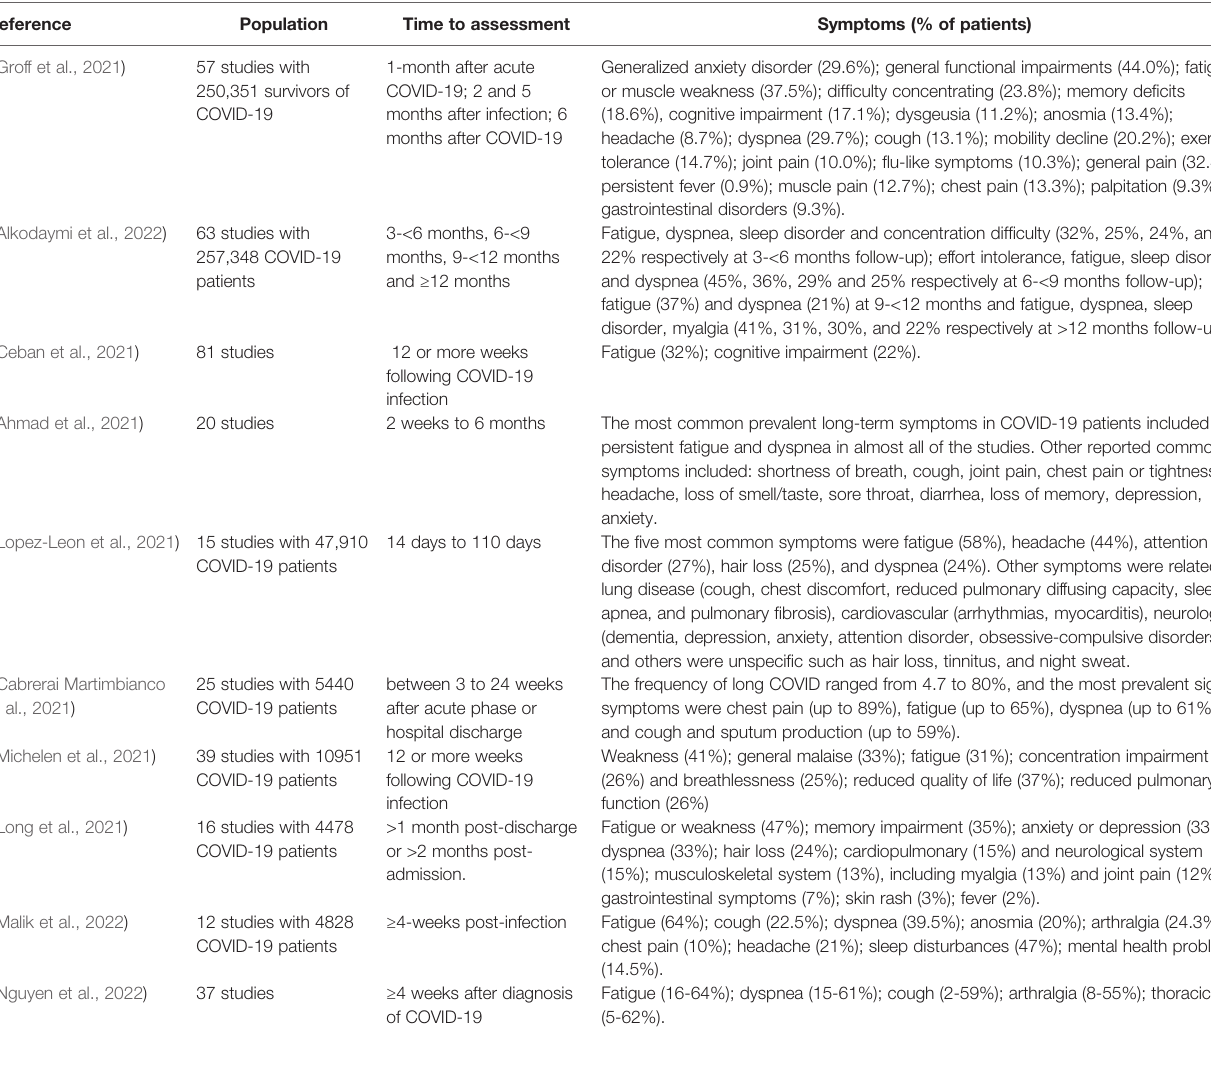
TABLE 1 | Summary of research on persistent symptoms in long